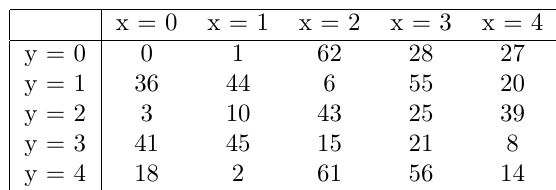
Table 2: The offsets of ρ